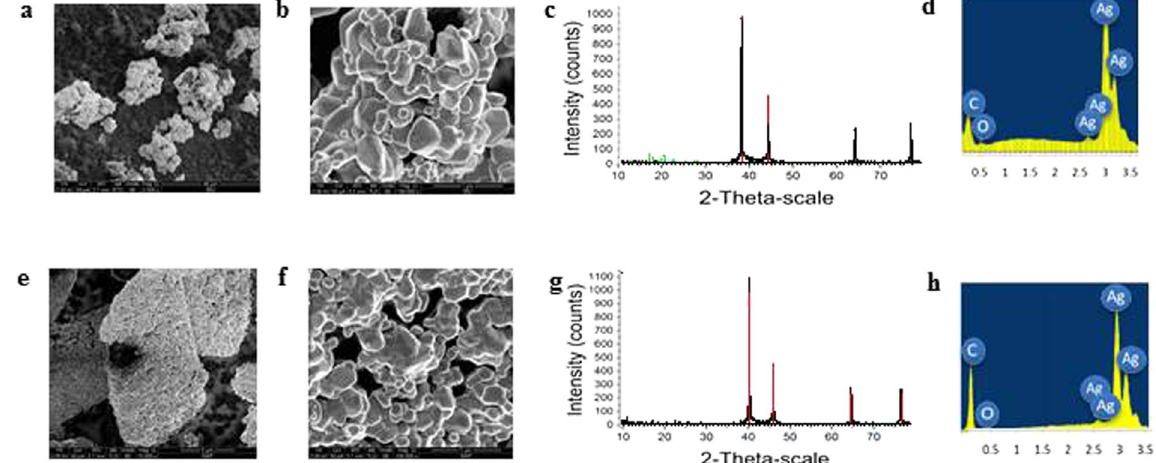
Figure 3. ( a ) – ( d ): ibu@Ag. SE-SEM: ( a ) bar - 40 µ m, ( b ) bar - 2 µ m. ( c ) XRD: black - ibu@Ag XRD; red - literature silver 58 ; green - literature ibuprofen 58 ( d ) EDAX. ( e ) – ( h ): nap@Ag. SE-SEM: ( e ) bar - 5 µ m, ( f ) bar